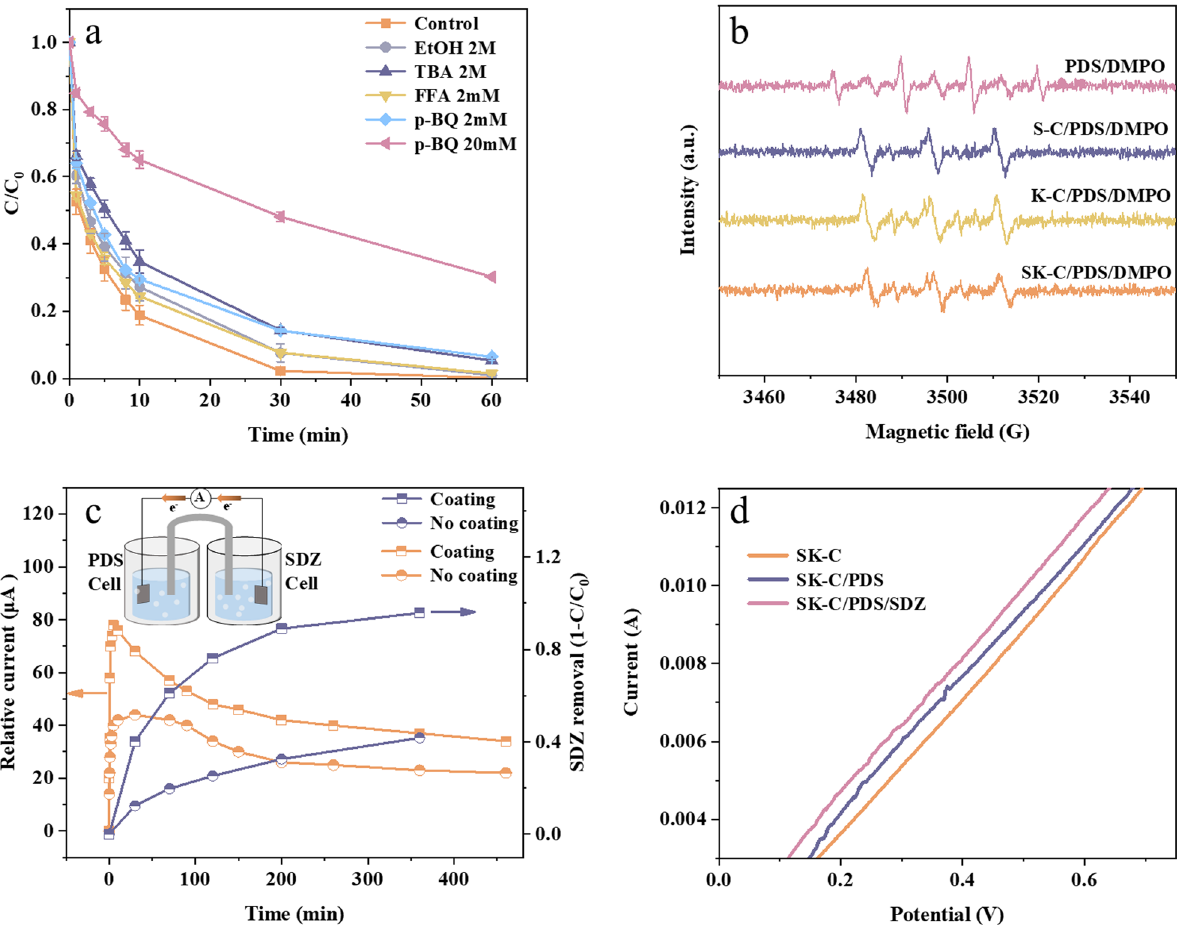
Fig. 3 The effects of EtOH, TBA, FFA and p-BQ ( a ) on SDZ degradation in SK-C/PDS system and EPR patterns with DMPO as the spin-trapping agents ( b ). Current flowing from the PDS cell to the SDZ cell and SDZ removal in GOP system ( c ). LSV spectra ( d ). Experimental conditions: [PDS]